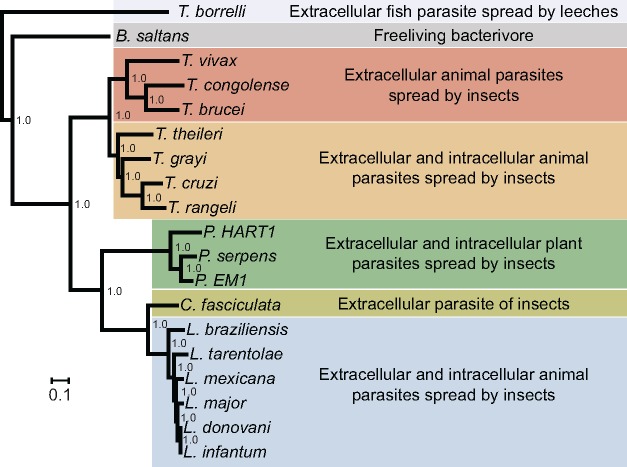
—Phylogenetic relationship between Kinetoplastida with substantial genome/transcriptome sequence availability. The relationship is based on an equal-sampled concatenated alignment of 375 ubiquitously conserved single copy genes (see Materials and Methods). Bootstrap replicate support values (percentages) are shown at internal nodes. Scale bar indicates the number of substitutions per site.